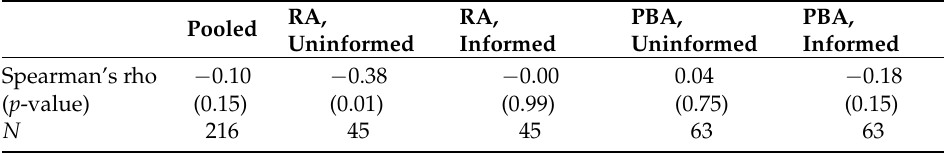
Table A12. Association between Graduate Management Admission Test (GMAT) performance and compliance.